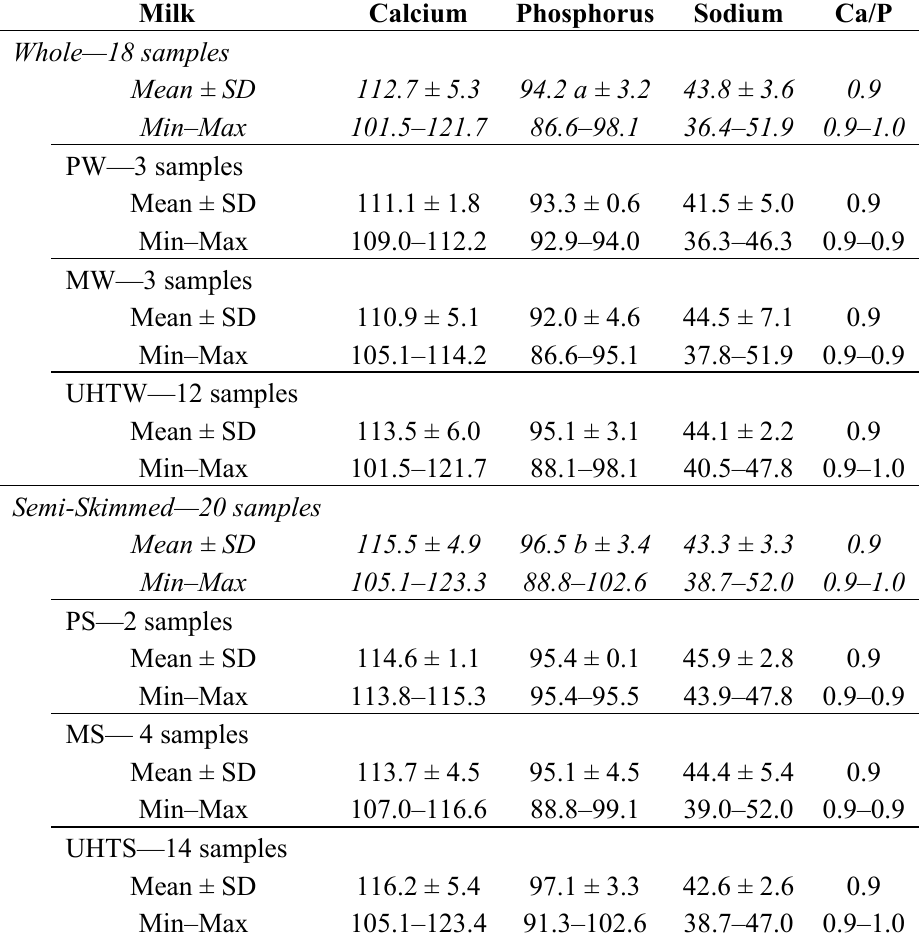
Table 1. Calcium, phosphorus and sodium content (mg/100 g) and molar ratio of Ca/P in whole and semi-skimmed commercial Italian milk. Data are shown as the mean with standard deviation (SD) and minimum and maximum